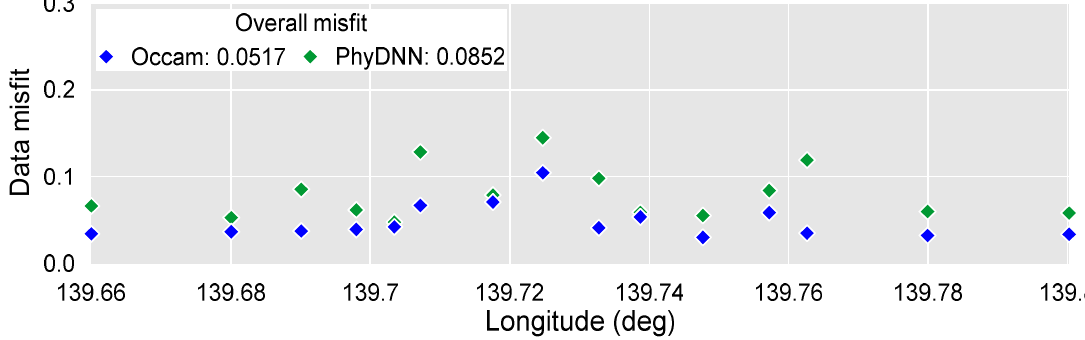
Figure 19. The data misfit of each individual site and the overall data misfit for all sites.